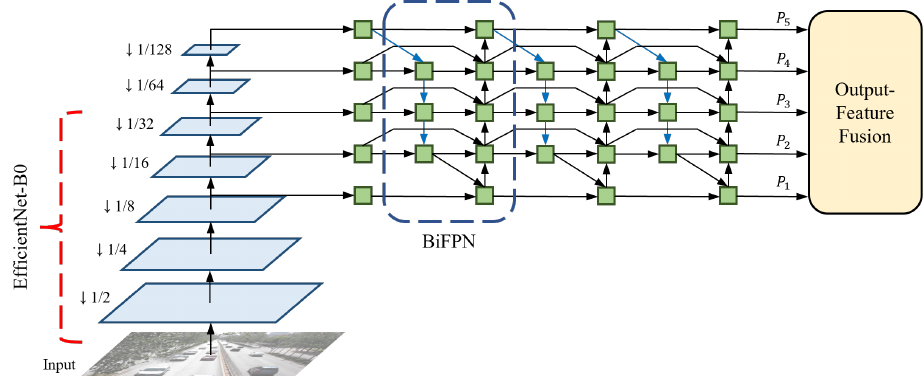
Figure 2. Backbone network architecture of our single-shot MOT